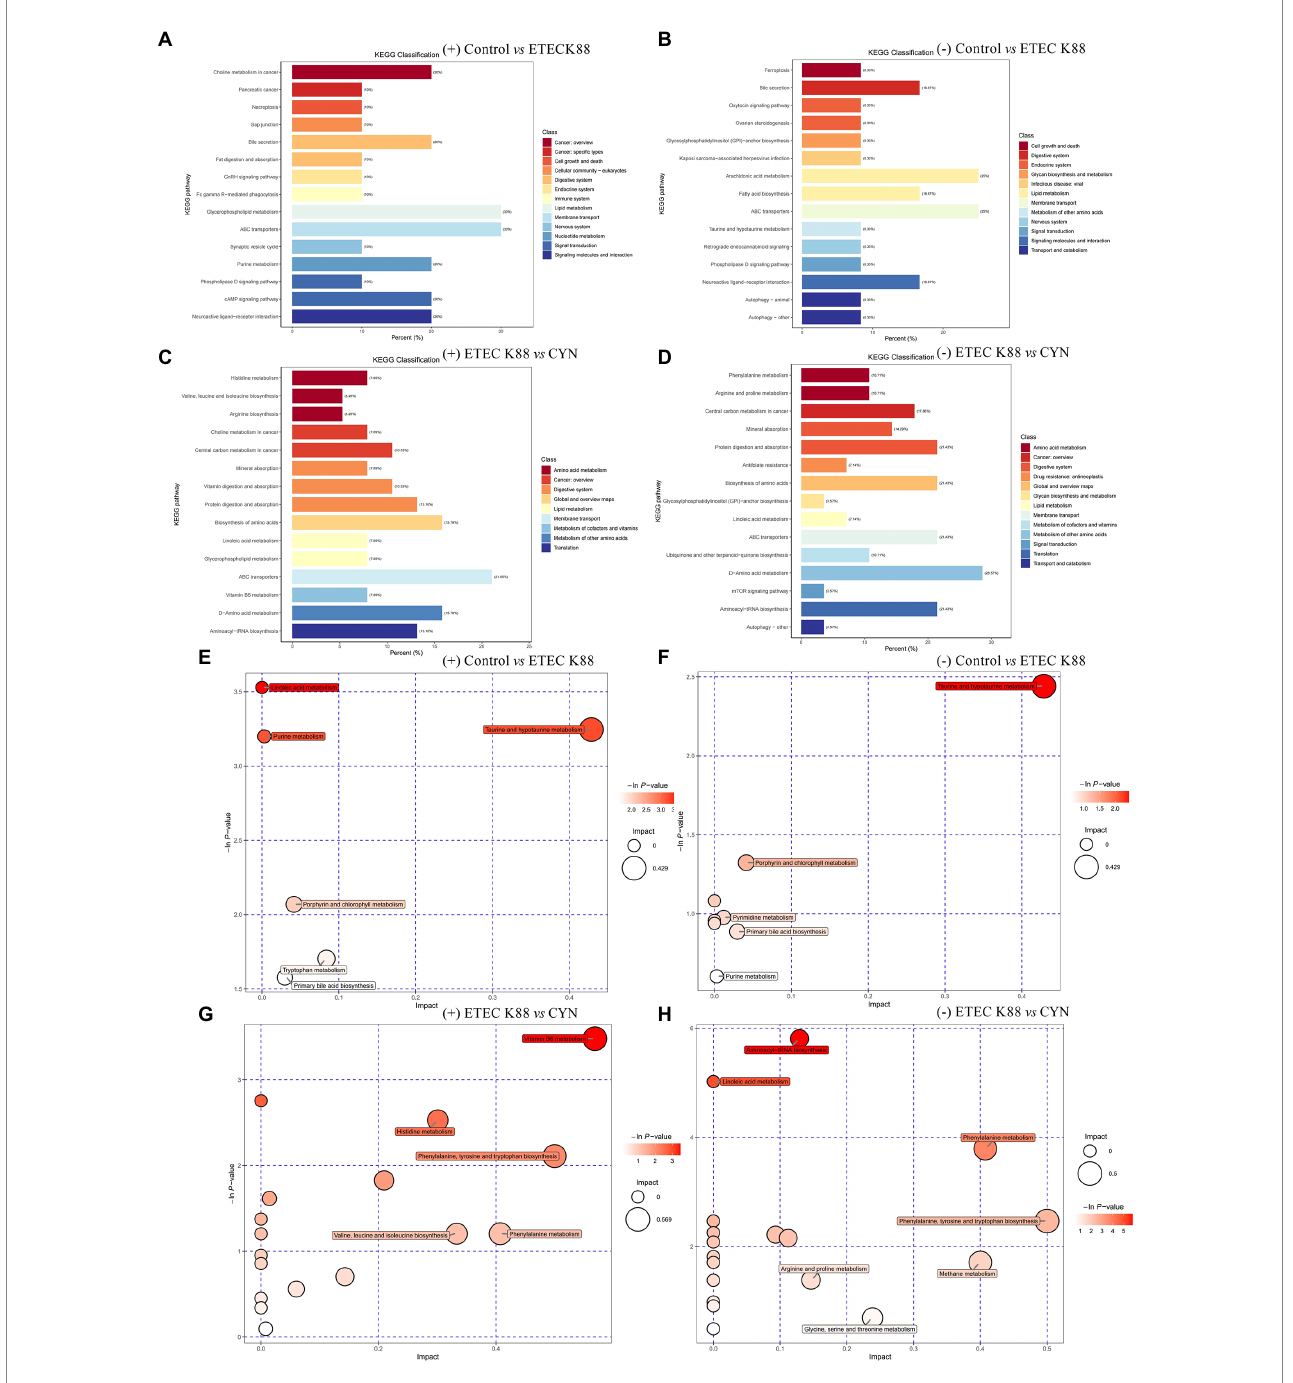
FIGURE 7 Major metabolic pathway analysis of serum samples between groups. (A–D) KEGG classification diagram on the ESI (+) and ( − ) mode. (E–H) Bubble plot of metabolic pathway based on the ESI (+) and ( − )